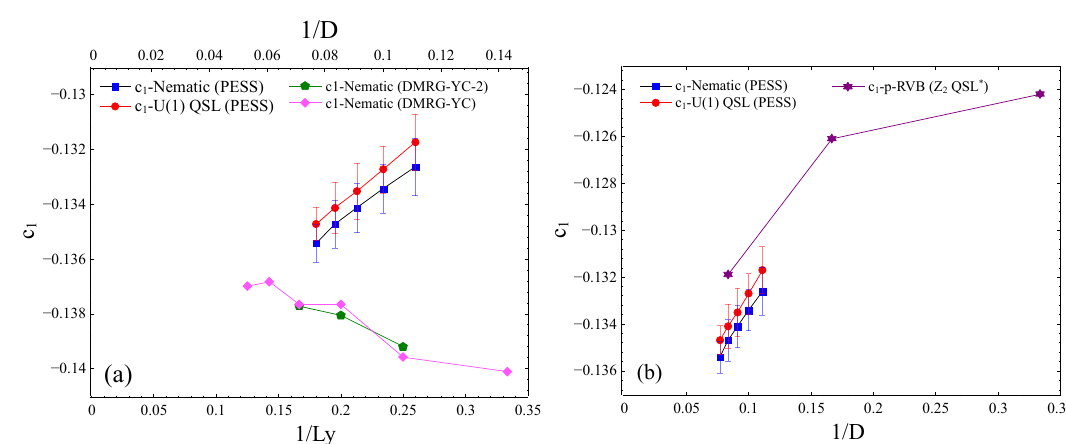
Figure 10: (Color online) Scaling of the PESS c mension, 1 / D , (a) compared to the scaling of DMRG results of Ref. [ 44, 58 ] with 1 / L (inverse cylinder width) for different cylinder geometries and (b) compared y with the 1 / D scaling of the p-RVB of Ref. [ 59 ] (the wave function for constructing the (cid:90) QSL ∗ state). Note that the values for the YC geometry should be considered 2 as upper bounds for the largest values of L